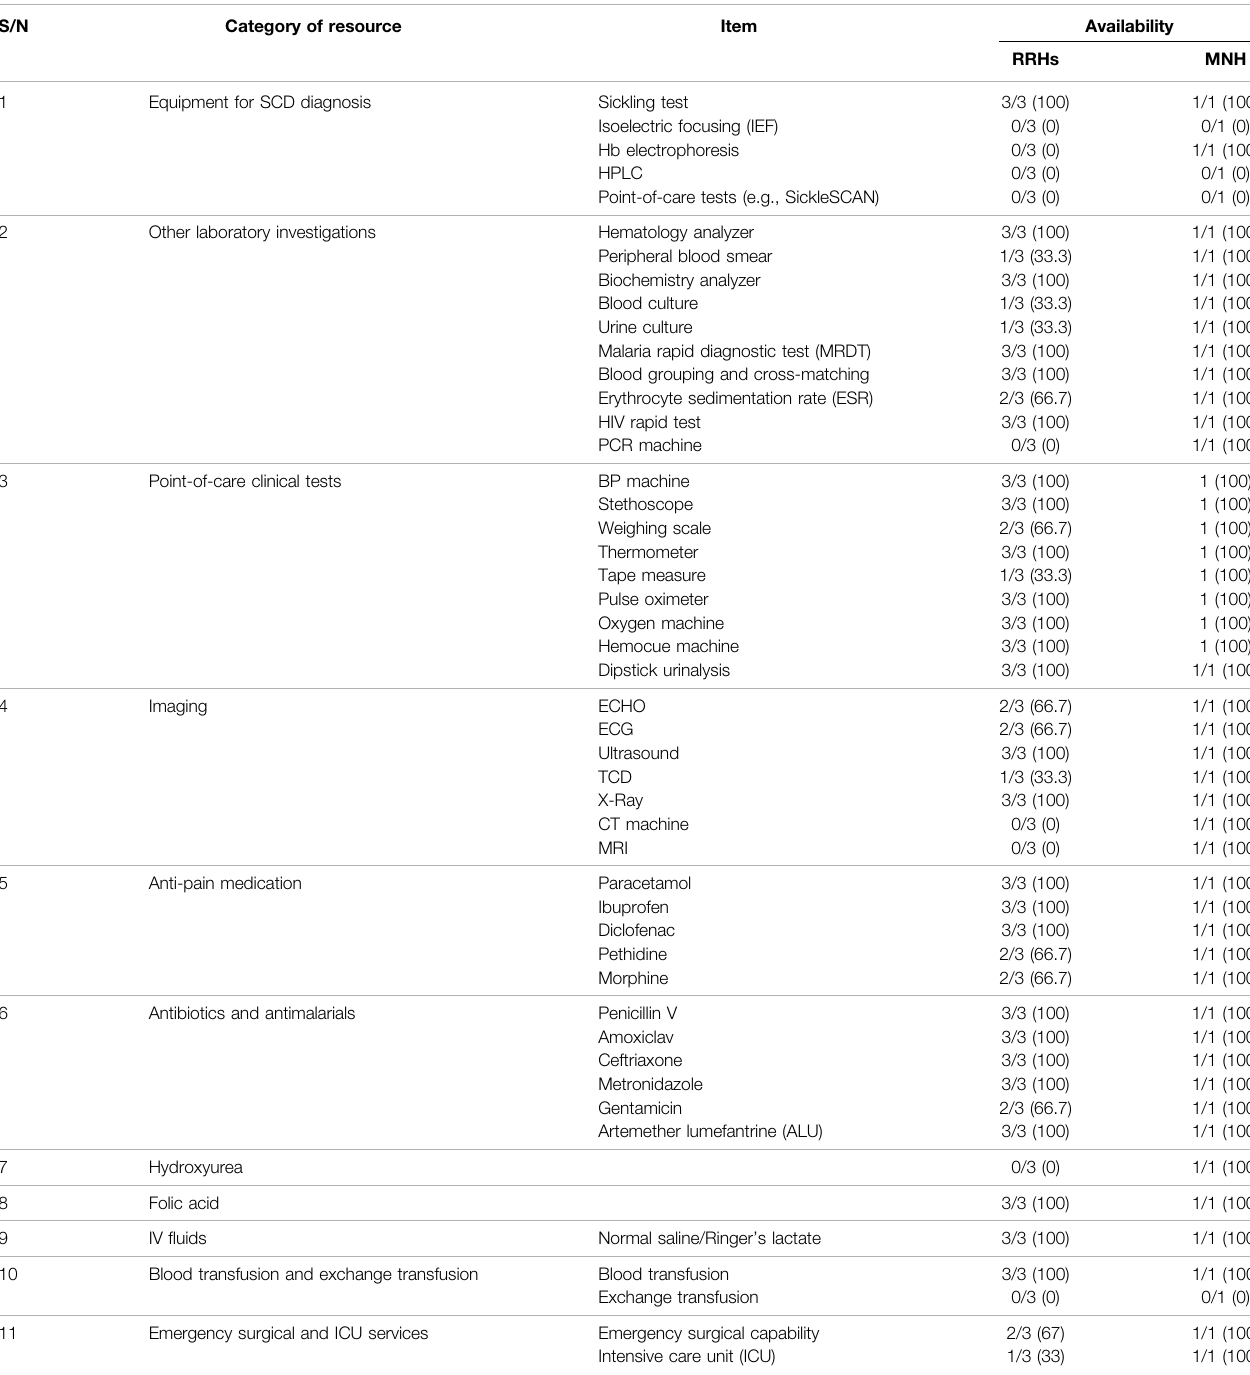
TABLE 3 | Resources available at healthcare facilities in Dar es Salaam S/N Category of